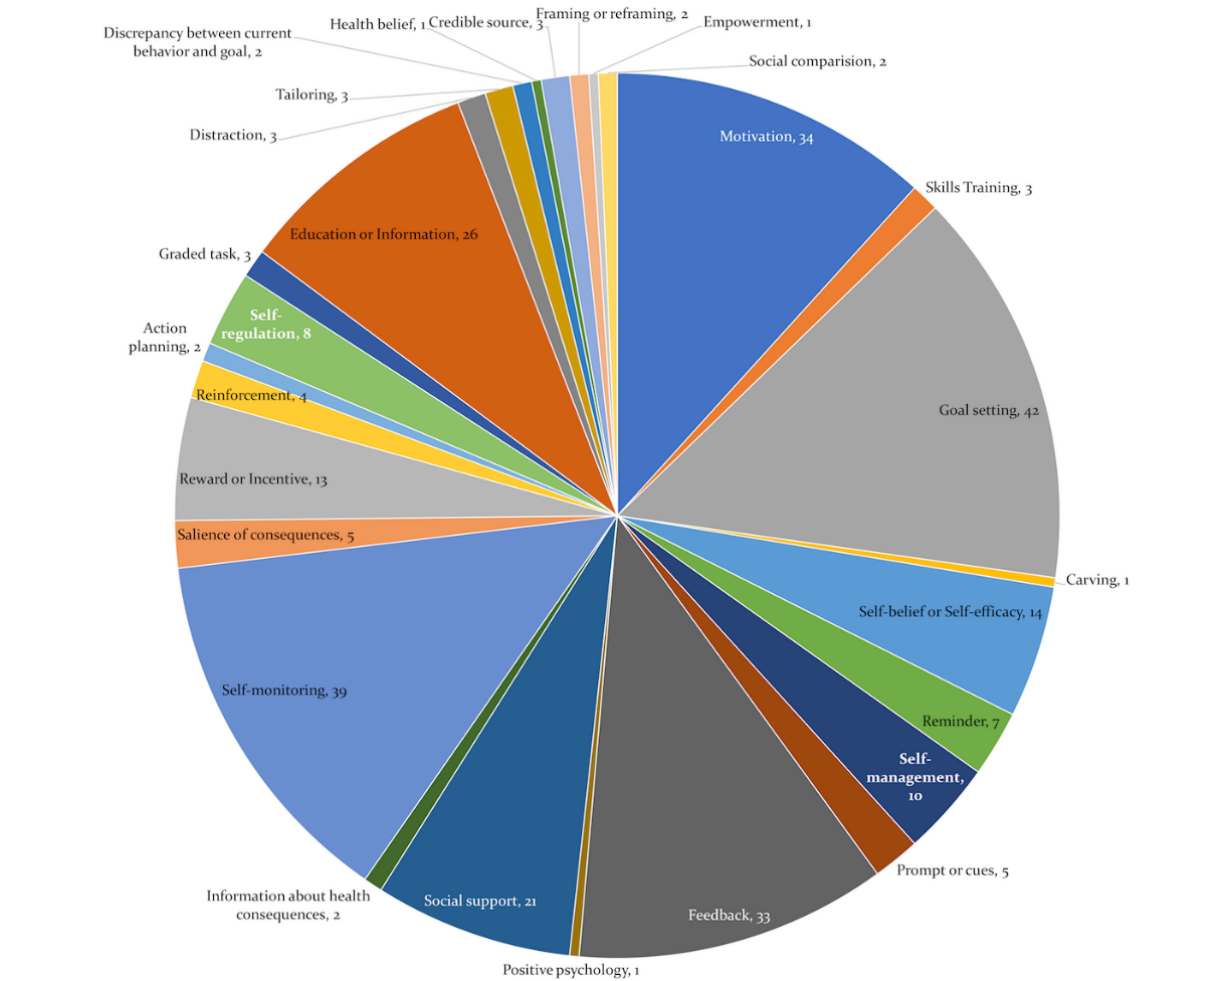
Figure 8. Frequency of different behavior change techniques